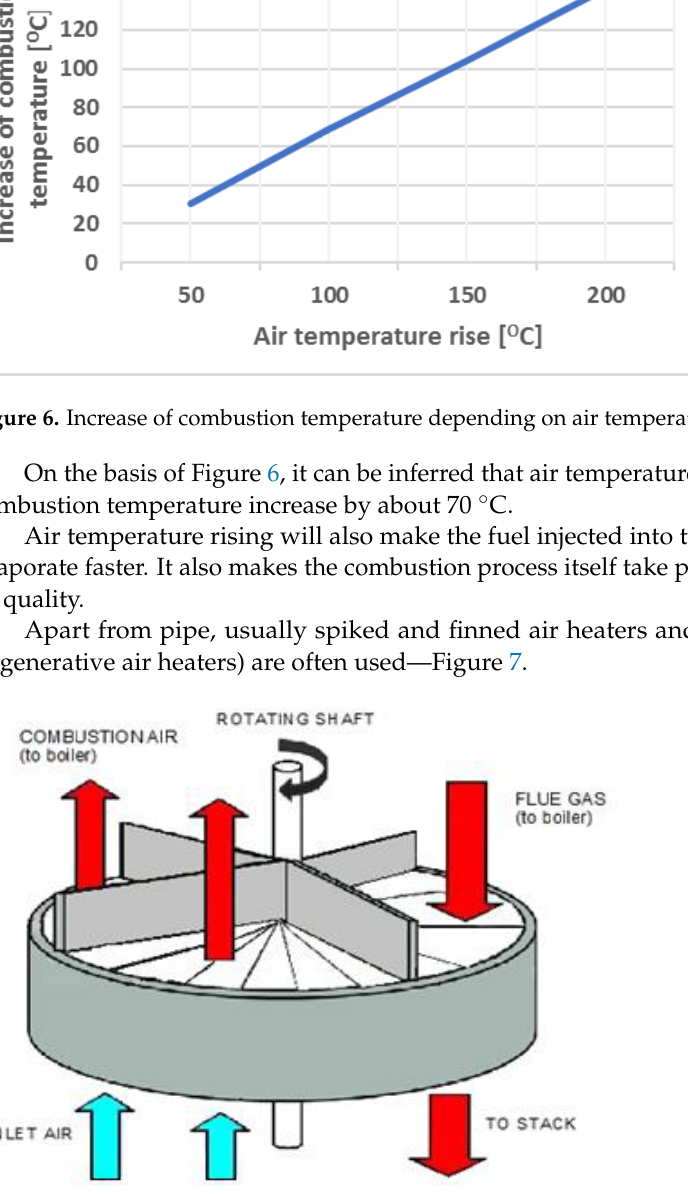
Figure 7. Rotary air heater (own drawing based on [14]).